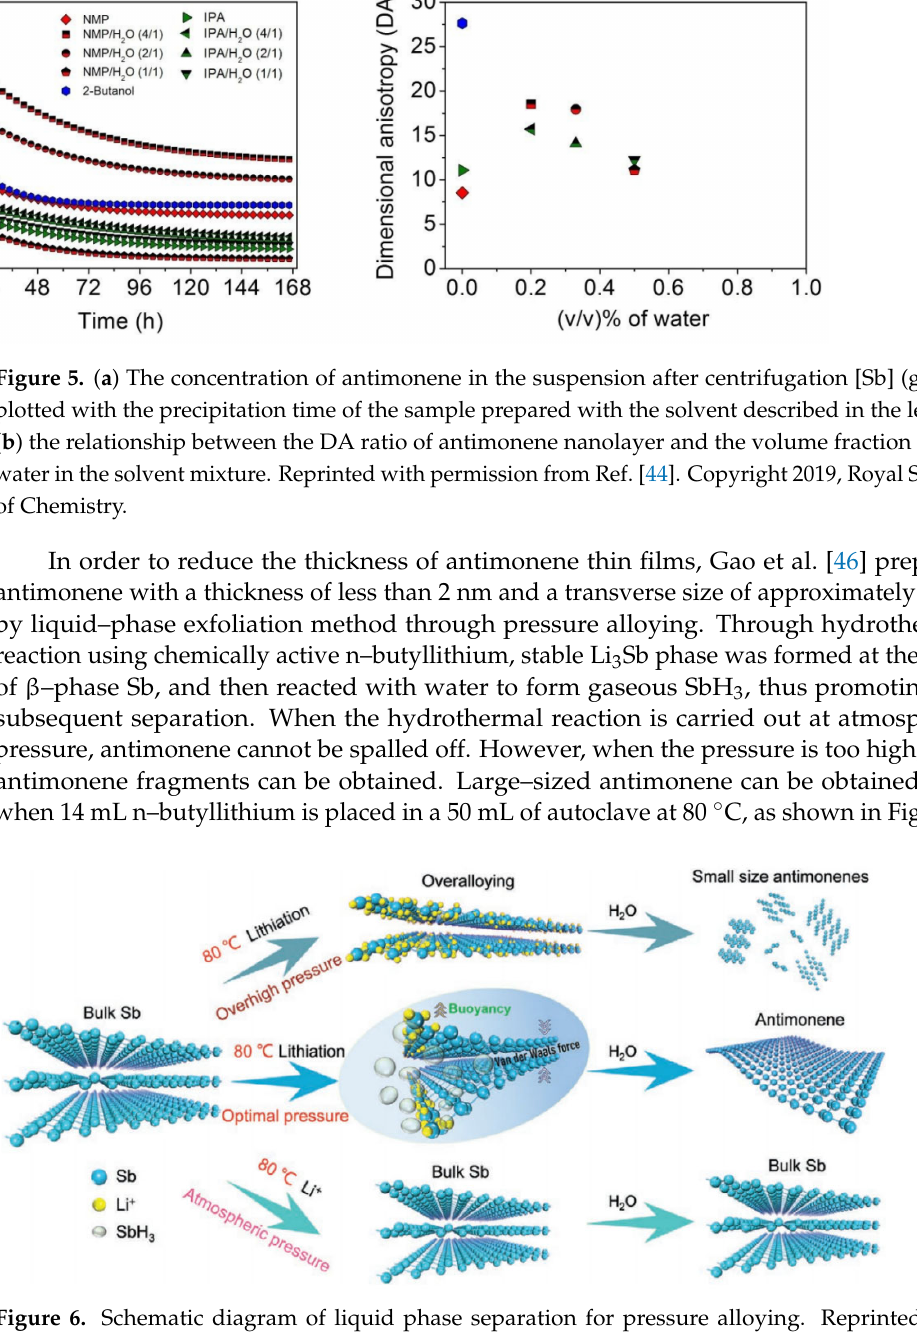
Figure 6. Schematic diagram of liquid phase separation for pressure alloying. Reprinted with permission from Ref. [46]. Copyright 2021, John Wiley and Sons.